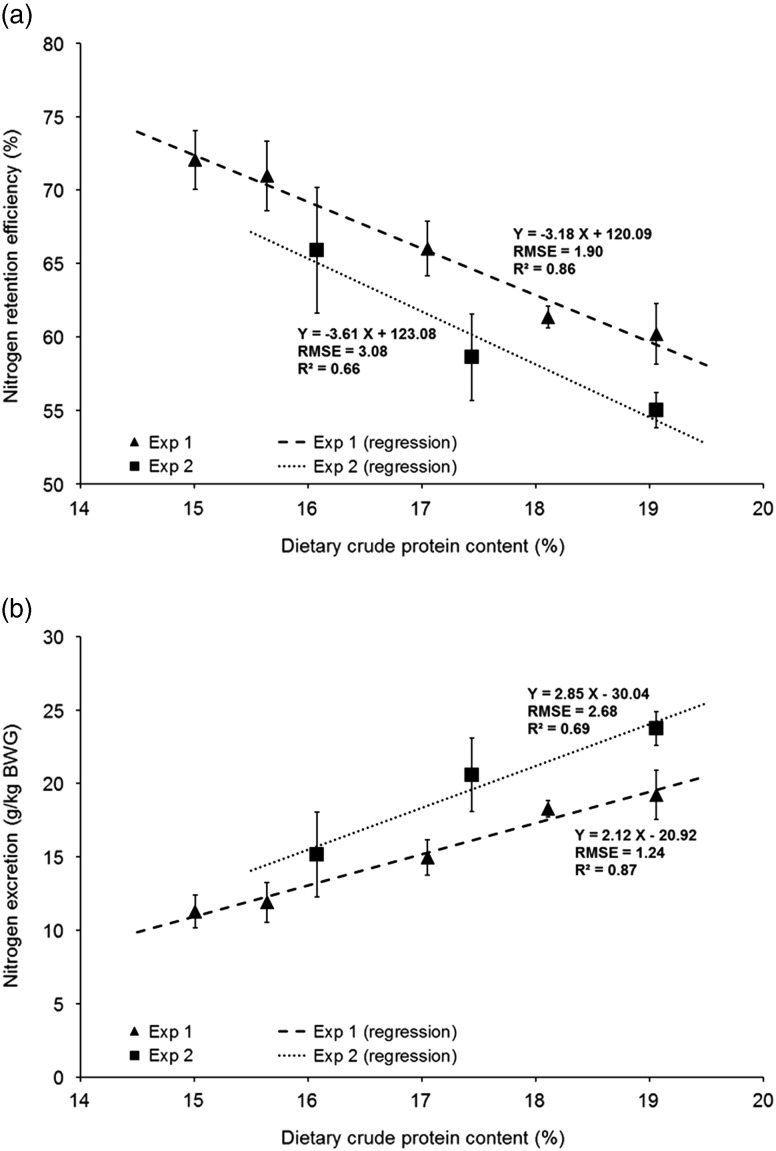
Nitrogen utilization in male Ross PM3 broilers according to the dietary CP content.
Average values (±SD) of (a) the efficiency of nitrogen utilization
(Neffi, equation (3))
and (b) nitrogen excretion (Nexc_BWG, equation (4)). Linear regressions were fitted
with pen values (n=8/treatment).